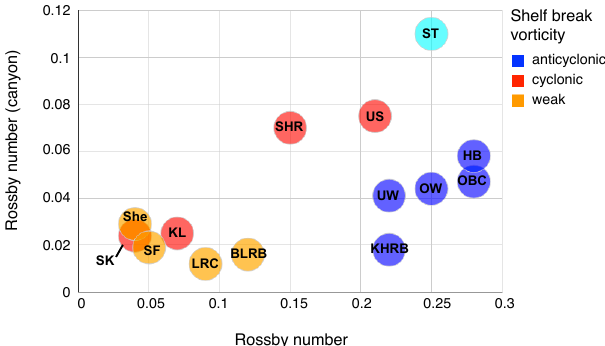
Figure 13. Zonal jet location upstream of the canyon. onshore due to negative vorticity in the canyon. This onshore flow, as well as compressing isopycnals, generates a trapped anticyclonic eddy within the canyon (Fig. 6a), which can per- sist to depths of 500 m.